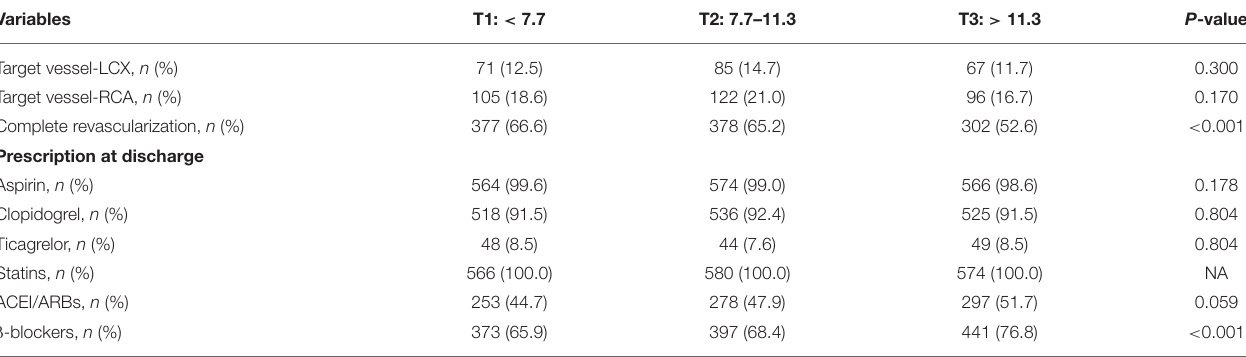
TABLE 2 | Adverse cardiovascular events according to MHR tertiles during follow-up. Adverse cardiovascular events